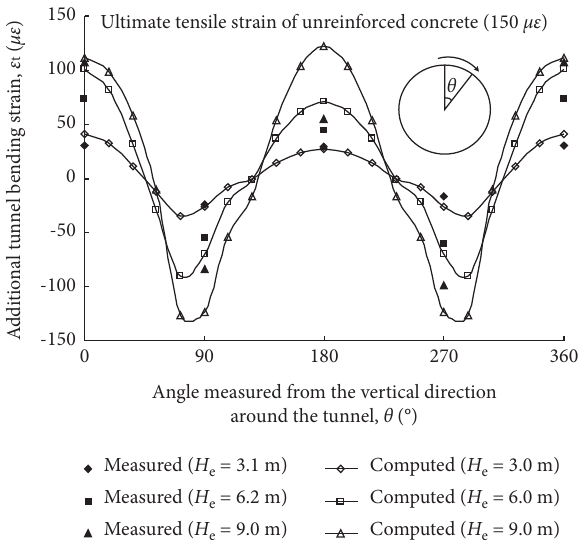
Figure 2: Comparison between measured and computed additional tunnel bending strain at section C-C.